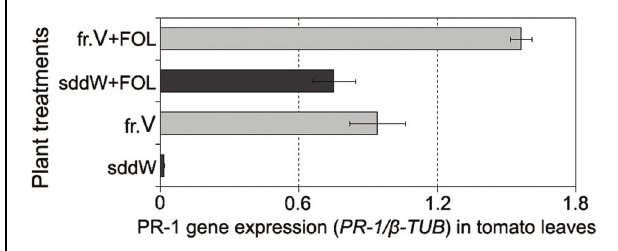
FIGURE 8 | Histogram showing an enhanced PR-1 expression in leaves of tomato seedlings in response to root treatment with the protein fraction V isolated from CS-20 biomass (fr.V) and after subsequent inoculation with the pathogen (fr.V + FOL) compared to corresponding control treatments. Seedling roots were exposed to fr.V for 24 h. Roots of control seedlings were inoculated with FOL after 24 h of incubation in sterile double distilled water (sddW).